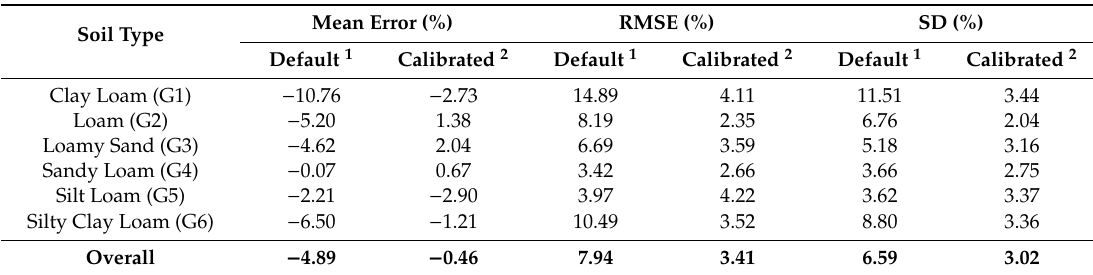
Table 5. Comparison of the default and calibrated sensors measurements with laboratory measurements of soil moisture (%) for the di ff erent soils.